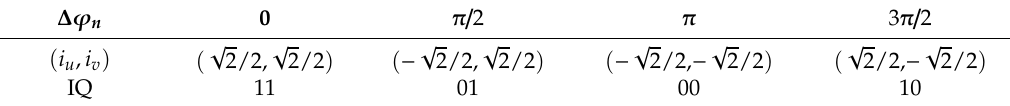
Table 1. Correspondence between the phase di ff erence and the demodulated symbols. ∆ ϕ n